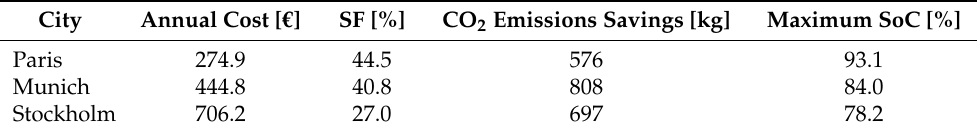
Table 9. Overall system KPIs for the studied locations.